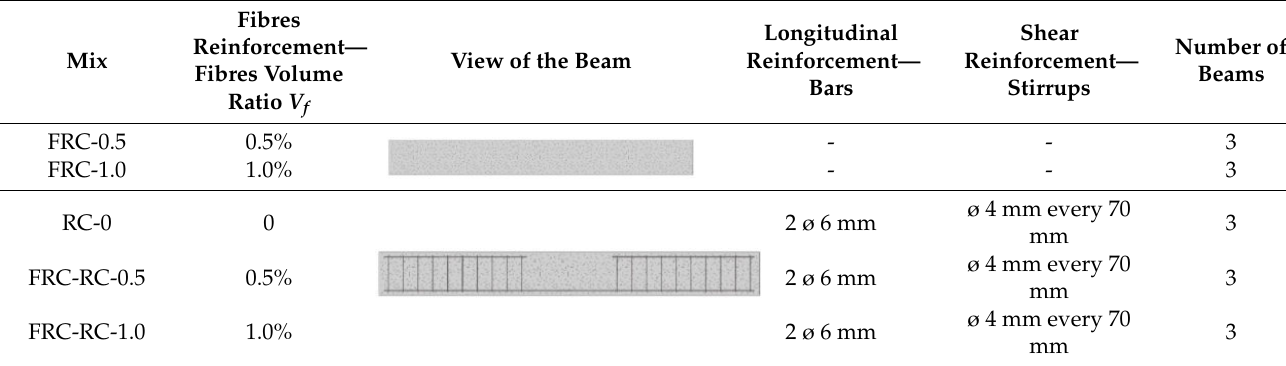
Figure 4. View of the RC/FRC-RC beam—four-points test layout. Table 4. Research